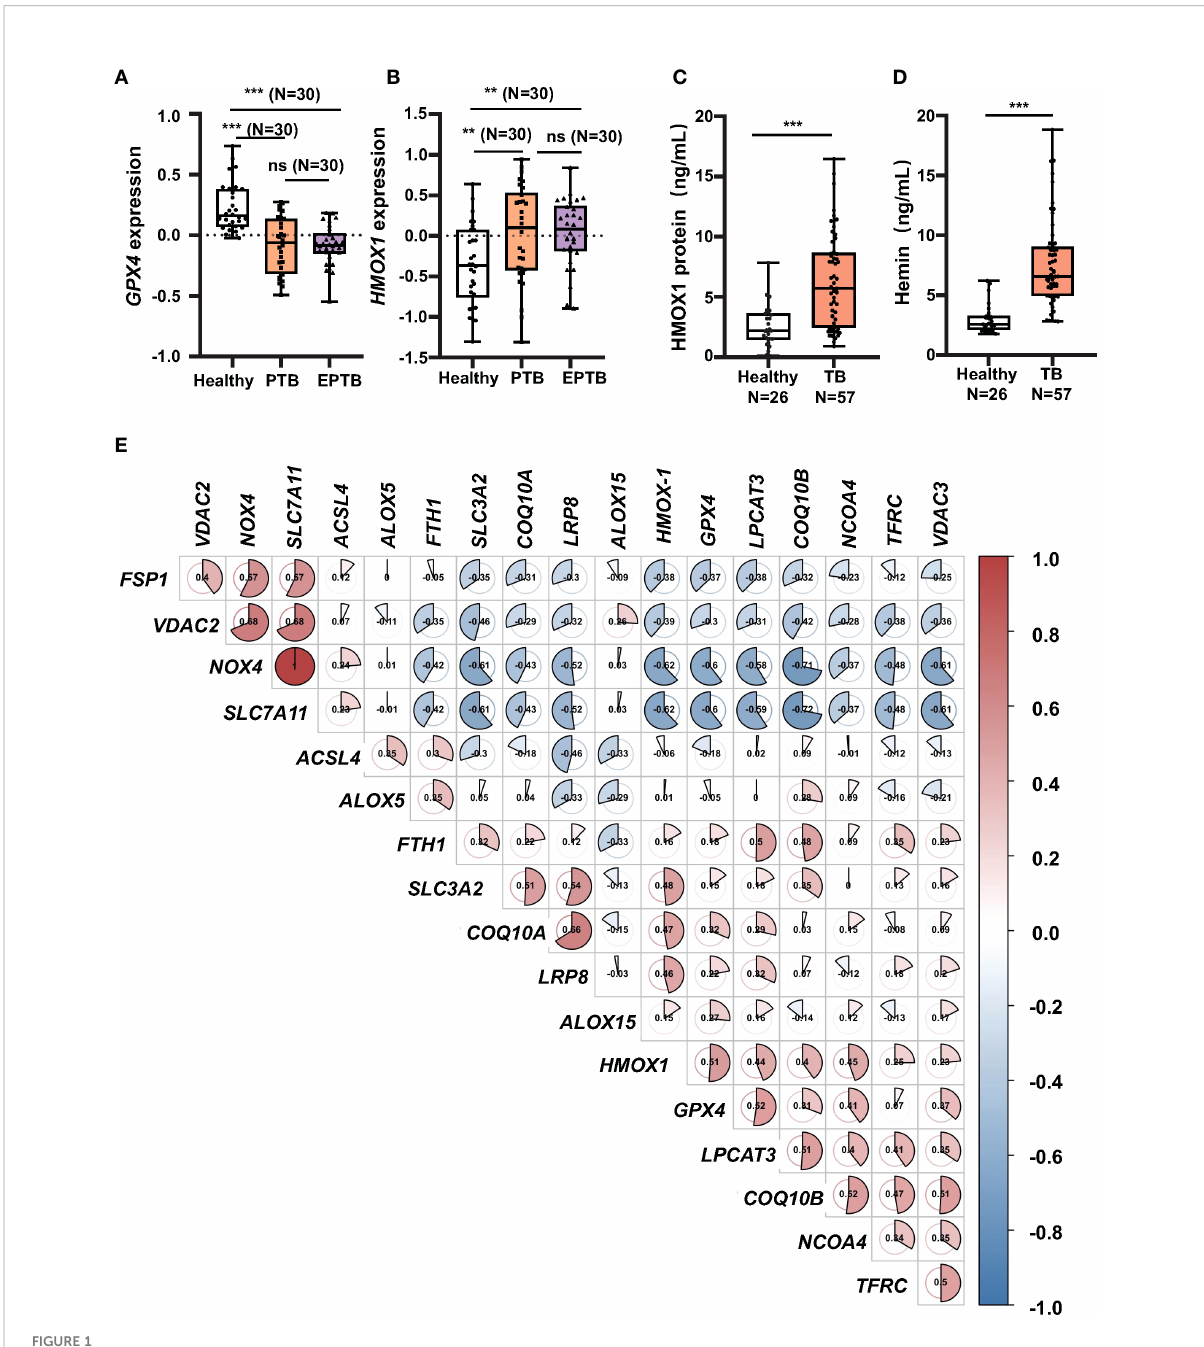
FIGURE 1 Increase of HMOX1 and decrease of GPX-4 in peripheral blood of TB patients. Peripheral blood from healthy individuals ( N = 30), patients with pulmonary TB (PTB, N = 30), and patients with extra-pulmonary TB (EPTB, N = 30) was collected for transcriptome analysis using GEO database GSE83456 (a transcriptome sequencing dataset of peripheral blood from TB patients). (A, B) The differential expression of transcript of the anti- lipid peroxidation factor GPX4 and (B) the oxidative stress regulator HMOX1 in the peripheral blood of TB patients. (C) More abundant circulating HO-1 protein in blood of patients with TB in comparison with healthy subjects as determined by ELISA. (D) Hemin content in peripheral blood of patients with TB in comparison with healthy subjects as determined by the Hemin Assay Kit. (E) Plotting CorrPlot map in Hiplot (https:// hiplot-academic.com/) showed the correlation of HMOX1 transcript with transcripts of ferroptosis markers in patients with PTB analyzed by Spearman. The color in the CorrPlot map represents the correlation coef fi cient, darker color represents stronger correlations. Red represents positive correlation while blue represents negative correlation. Cluster analysis using the ward.D2 method in Hiplot. Data were processed using GraphPad Prism 8.0.1 software and ImageJ 1.52.a. Unpaired t -test was used to analyze the differential changes of two groups. One-way ANOVA and Tukey ’ s multiple comparisons test was used to analyze the differential changes of multiple groups. Data represented mean ± SD; signi fi cant differences were indicated with asterisks (** p < 0.01; *** p < 0.001). ns, no statistical